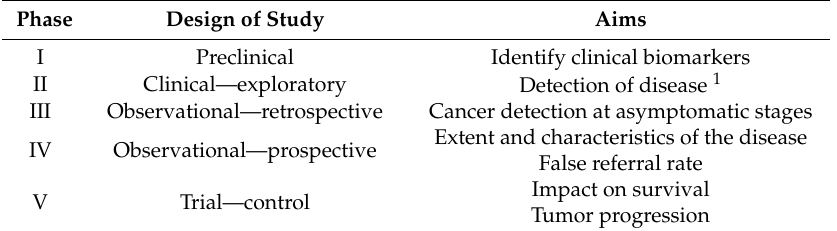
Table 1. Phases of biomarkers development and validation in cancer